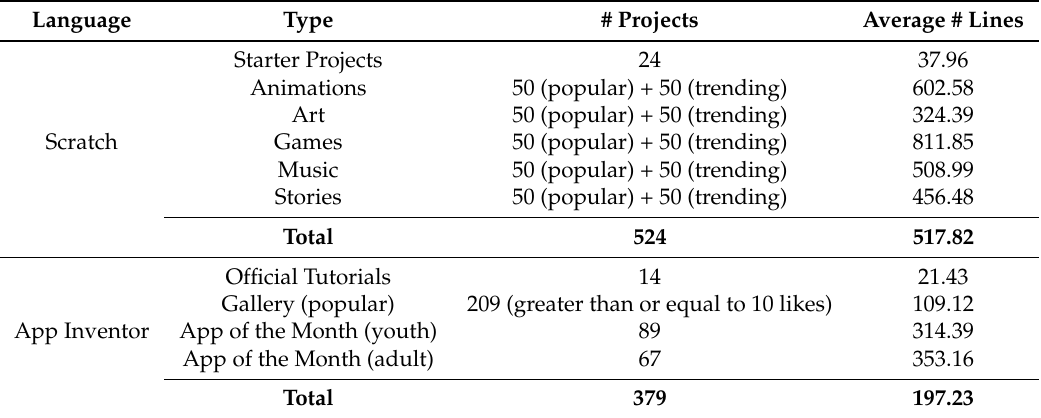
Table 2. Statistics of the selected projects.